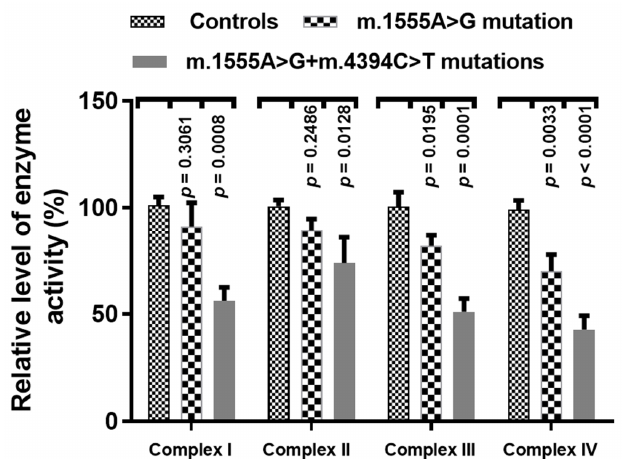
Figure 9. Enzymatic activities of respiratory chain complexes in three patients with both the m.1555A>G and m.4394C>T mutations, three patients with only the m.1555A>G mutation and three controls.